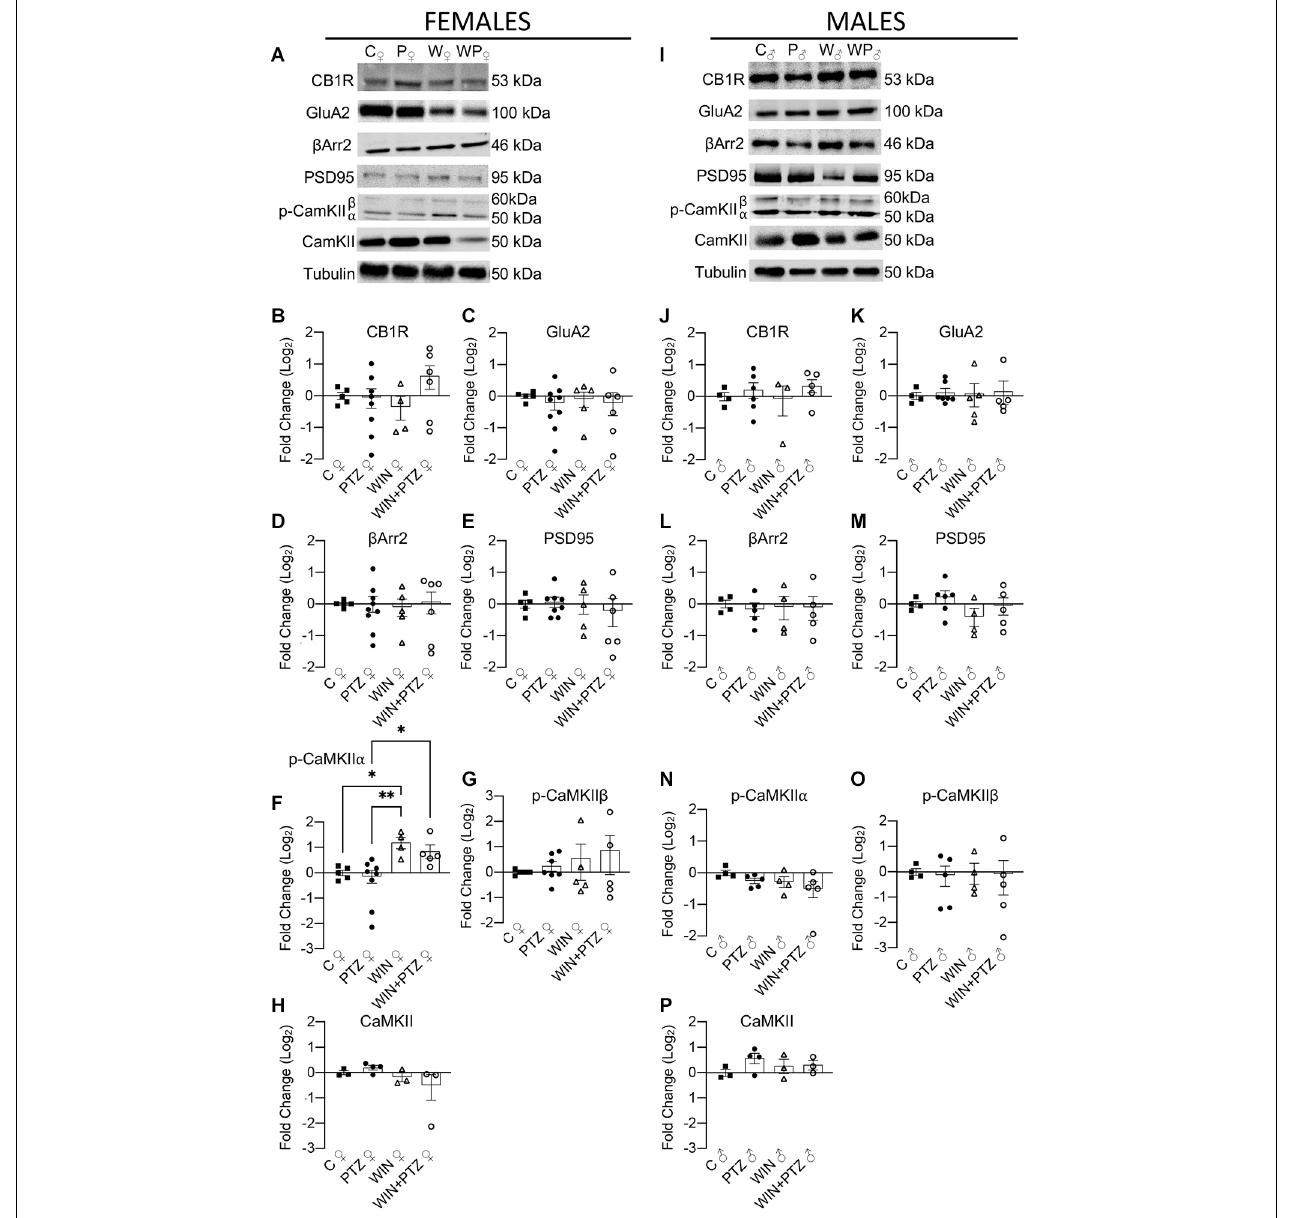
FIGURE 4 | Expression levels of proteins obtained from a fraction enriched in cytoplasmic proteins/proteins bound to small organelles. (A) Representative Western blots of CB1R, GluA2R, β Arr2, PSD95, p-CaMKII and total CaMKII in females and (I) males. (B–H) Quantification of (A) (Females. CB1R: C, n = 5; PTZ, n = 8; WIN, n = 4; WIN + PTZ, n = 6; GluA2: C, n = 5; PTZ, n = 9; WIN, n = 5; WIN + PTZ, n = 6; β Arr2: C, n = 5; PTZ, n = 9; WIN, n = 5; WIN + PTZ, n = 6; PSD95: C, n = 5; PTZ, n = 8; WIN, n = 5; WIN + PTZ, n = 6, p -CaMKII α : C, n = 5; PTZ, n = 8; WIN, n = 4; WIN + PTZ, n = 5; p -CaMKII β : C, n = 5; PTZ, n = 7; WIN, n = 5; WIN + PTZ, n = 5; total CaMKII: C, n = 3; PTZ, n = 4; WIN, n = 3; WIN + PTZ, n = 3). (J–P) Quantification of (D) (Males. CB1R: C, n = 4; PTZ, n = 6; WIN, n = 3; WIN + PTZ, n = 5; GluA2: C, n = 4; PTZ, n = 7; WIN, n = 5; WIN + PTZ, n = 5; β Arr2: C, n = 4; PTZ, n = 5; WIN, n = 4; WIN + PTZ, n = 5; PSD95: C, n = 4; PTZ, n = 6; WIN, n = 4; WIN + PTZ, n = 5, p -CaMKII α : C, n = 4; PTZ, n = 5; WIN, n = 4; WIN + PTZ, n = 5; p -CaMKII β : C, n = 4; PTZ, n = 5; WIN, n = 4; WIN + PTZ, n = 5; total CaMKII: C, n = 3; PTZ, n = 4; WIN, n = 3; WIN + PTZ, n = 3). Tubulin was used as protein loading control for all gels. ∗ p < 0.05 and ∗∗ p < 0.01, one-way ANOVA with Tukey’s multiple comparisons post hoc